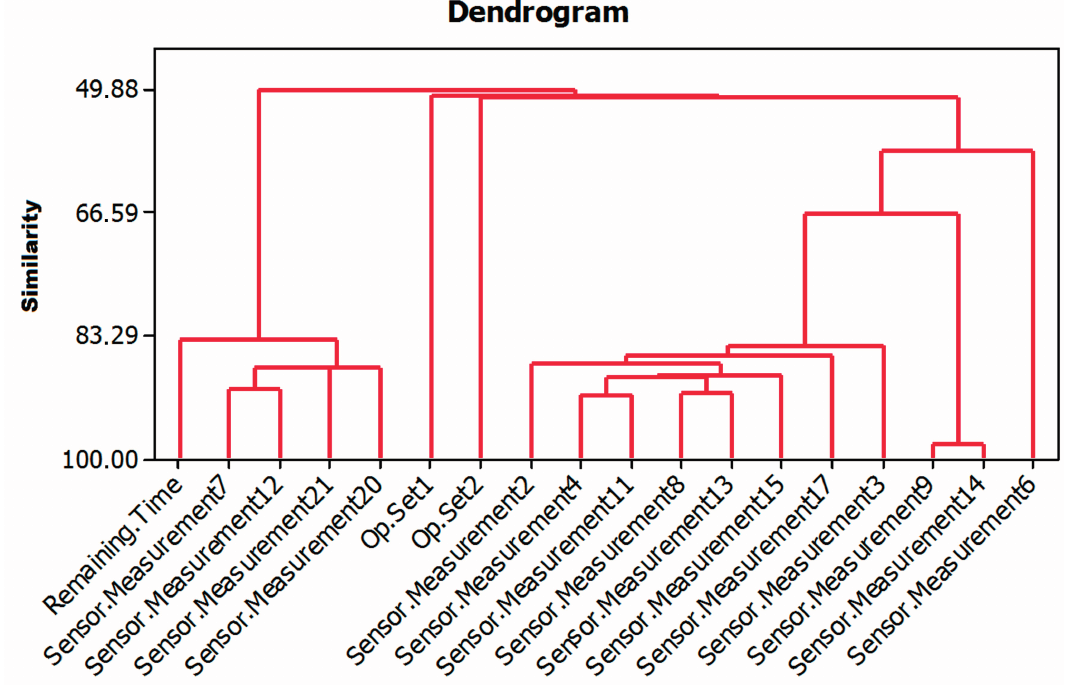
Figure 3. Dendrogram of the remaining useful life variable and the other variables after the dimensional